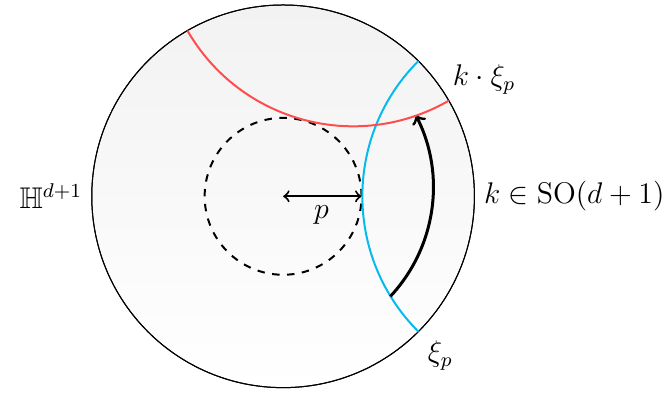
Figure 6 . k 2 SO( d + 1) action on (cid:24) p in the mean-value operator M